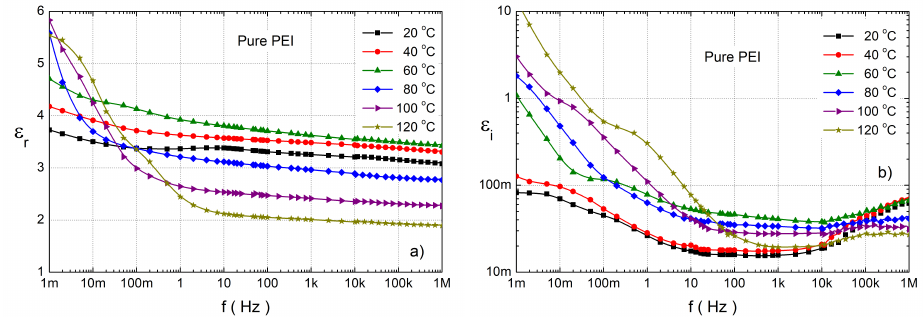
Figure 4. The frequency dependence of the relative real ( a ) and the imaginary ( b ) part of the complex relative permittivity for pure PEI at various temperatures.